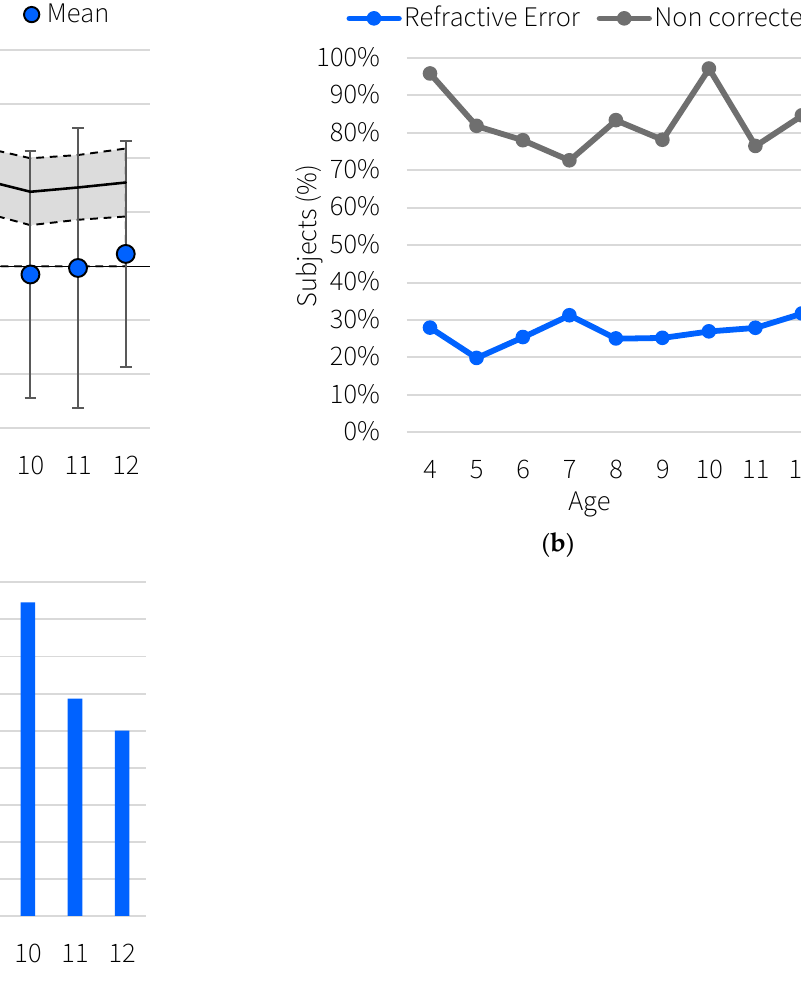
Figure 1. ( a ) Mean value of measured refractions (D) as a function of age. The error bars indicate the standard deviation for each age group, and the shaded area represents the expected values according to McCullough et al. [24] ( b ) In blue, percentage of subjects in whom potential refractive errors were found according to the age. In gray, percentage of subjects with uncorrected refraction. ( c ) Ratio of myopes and hyperopes for each age.